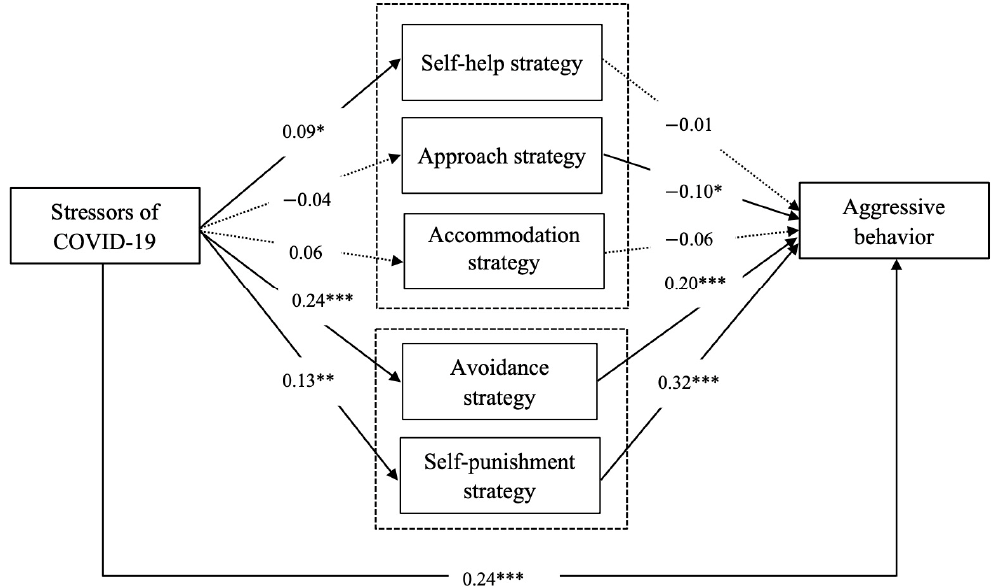
Figure 2. Path analyses for the direct and indirect effects in the present study. Note. Significant relationships are represented by solid lines and insignificant relationships are represented by dashed lines. * p < 0.05. ** p < 0.01. *** p < 0.001.